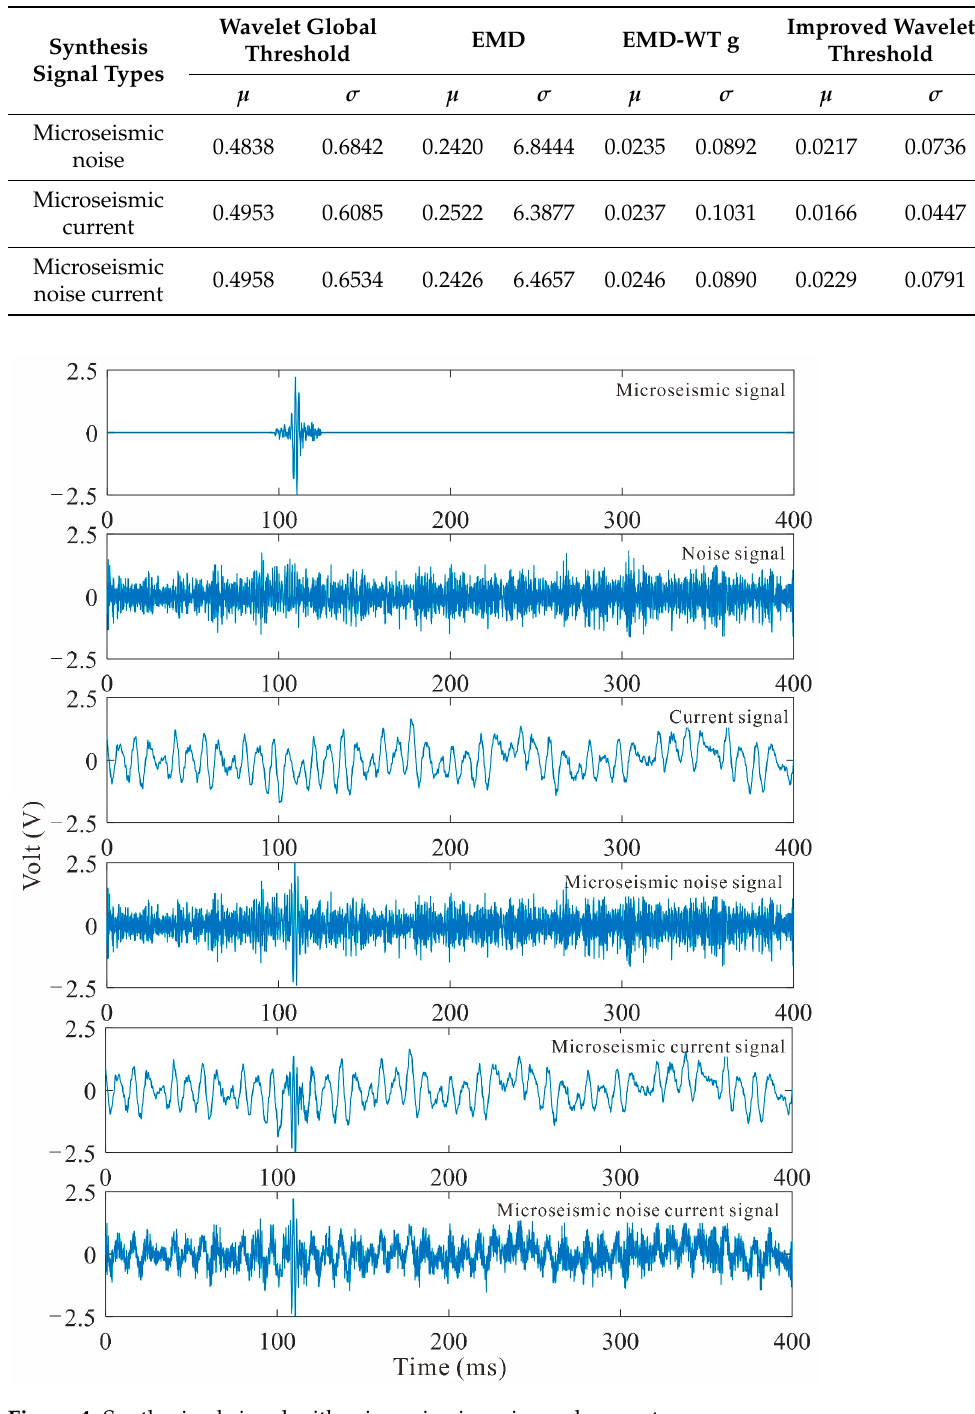
Table 3. Comparison of evaluation indicators for different types of synthetic signals.